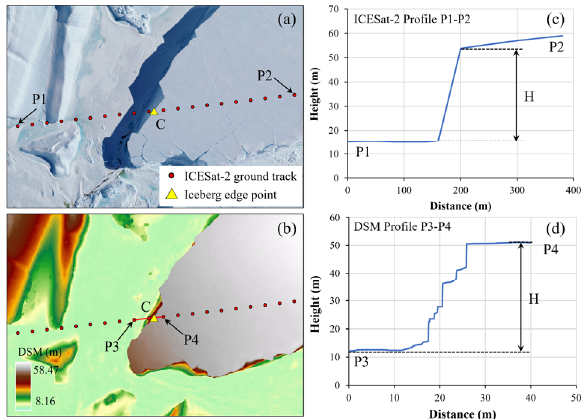
Figure 4 . (a) Ortho-mosaic and ICESat-2 ground track points. (b) DSM and ICESat-2 ground track points. (c) The elevation profile of ICESat-2. (d) The elevation profile of DSM.